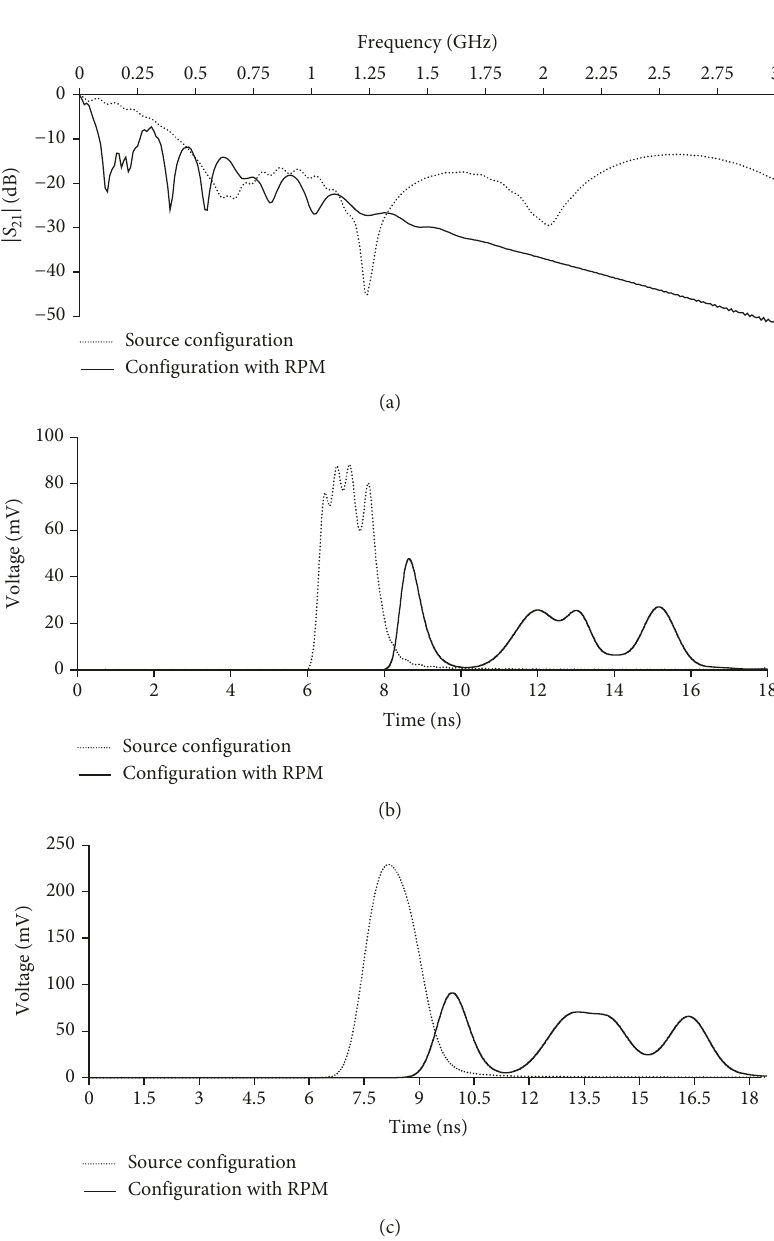
21 |, and output voltage waveforms for a USP with